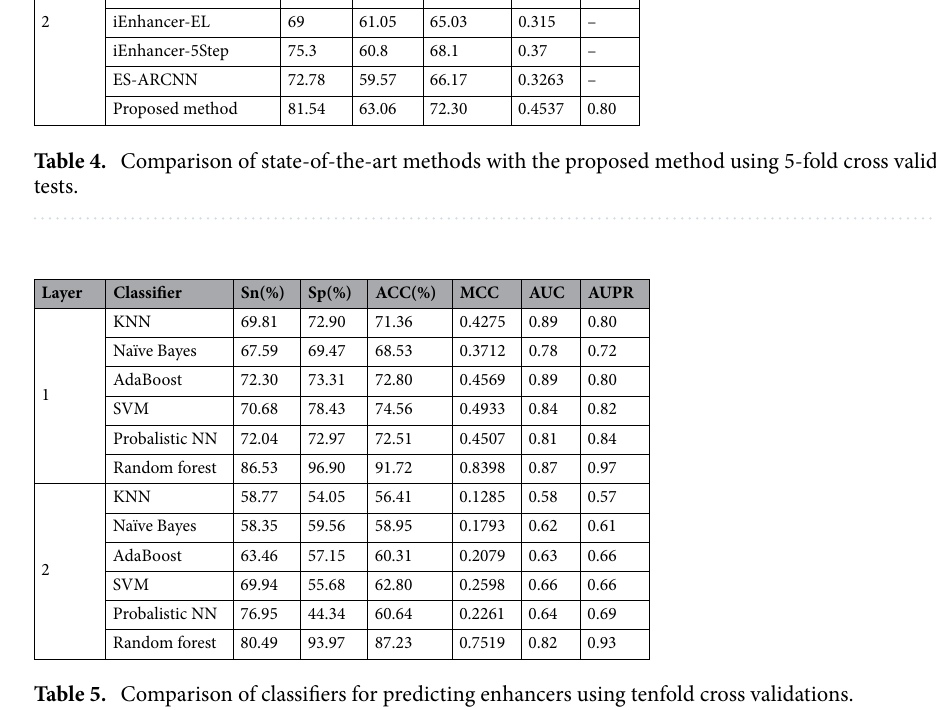
Table 5. Comparison of classifiers for predicting enhancers using tenfold cross